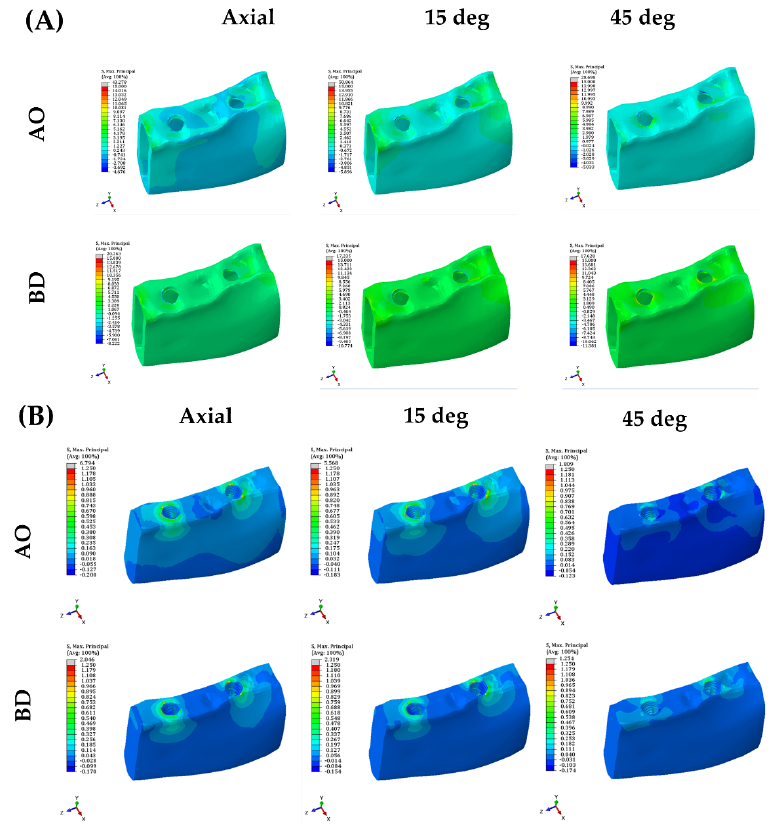
Figure 13. Overall stress distribution of the cortical and cancellous bones in both models. ( A ) cortical bone; ( B ) cancellous bone.